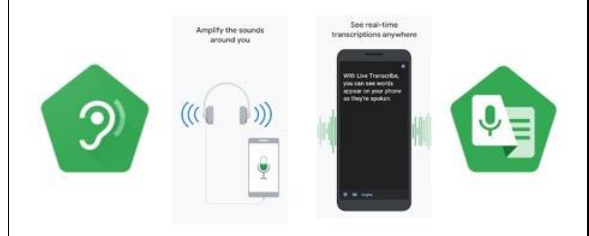
Figure 2. Google’s Sound amplifier and Live Transcribe apps Source: https://www.disabili.com/prodotti/articoli- qprodotti/sound-amplifier-e-live-transcribe-le-novita-da-google-